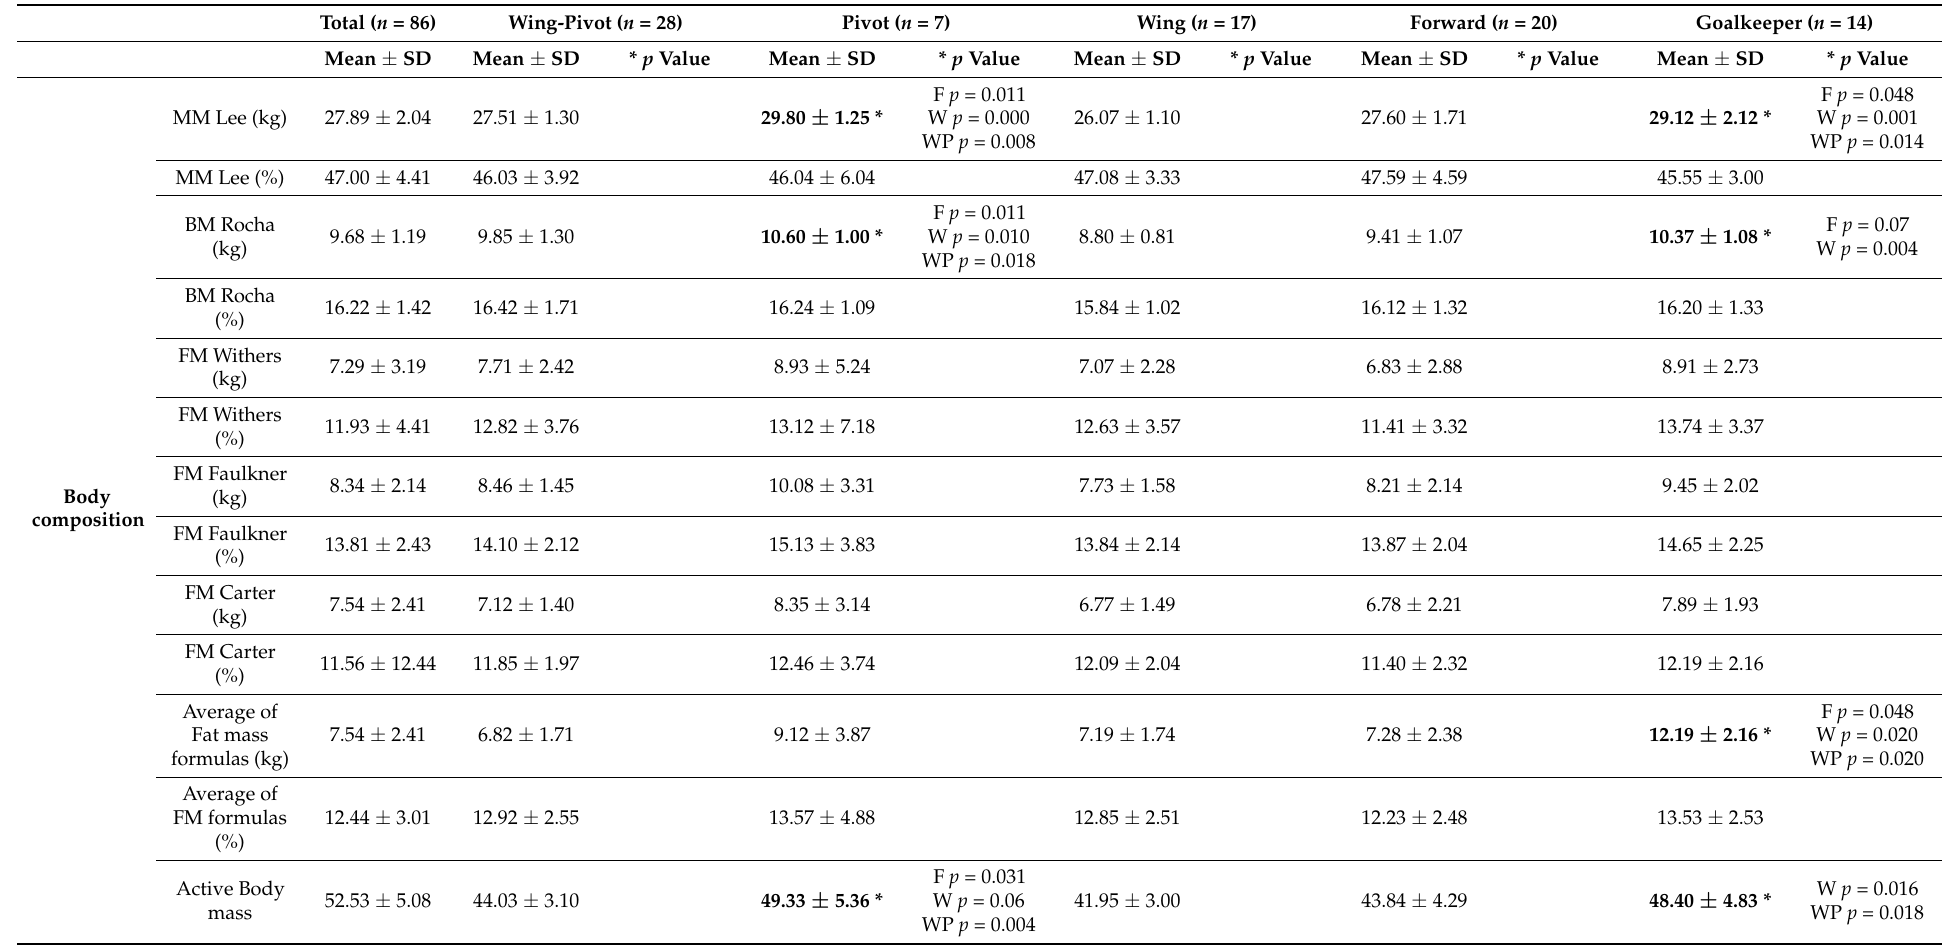
Table 2. Average and deviation of BC values, index, and somatotype values, and classification according to tactical